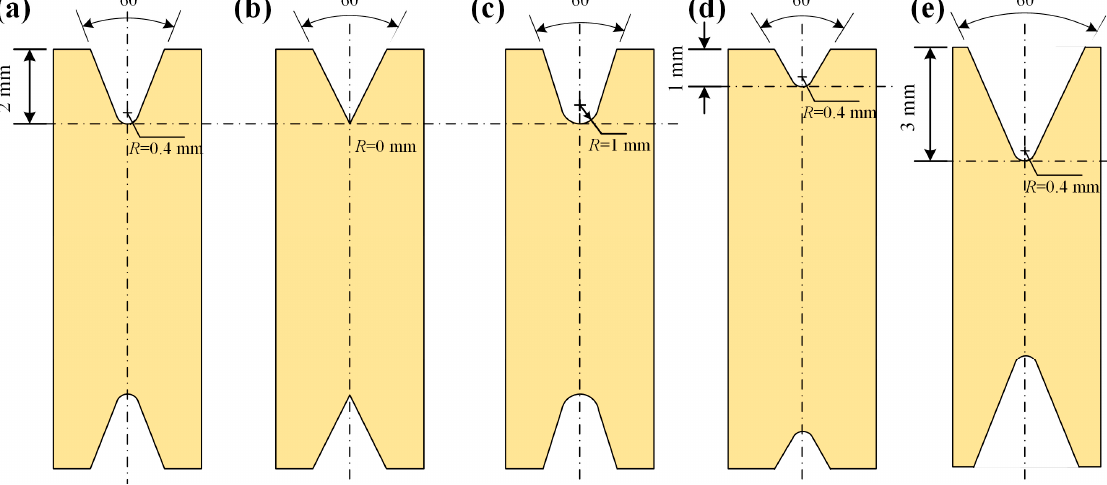
Figure 15. Fracture toughness at crack initiation of five SENB 20 models with different depth and bottom radiuses.